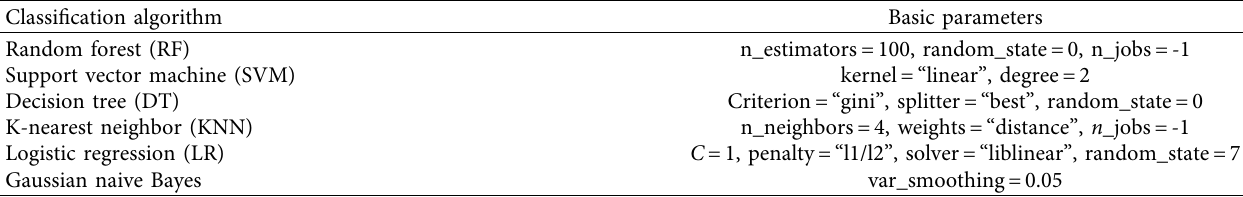
Table 4: Parameter settings for classifier.